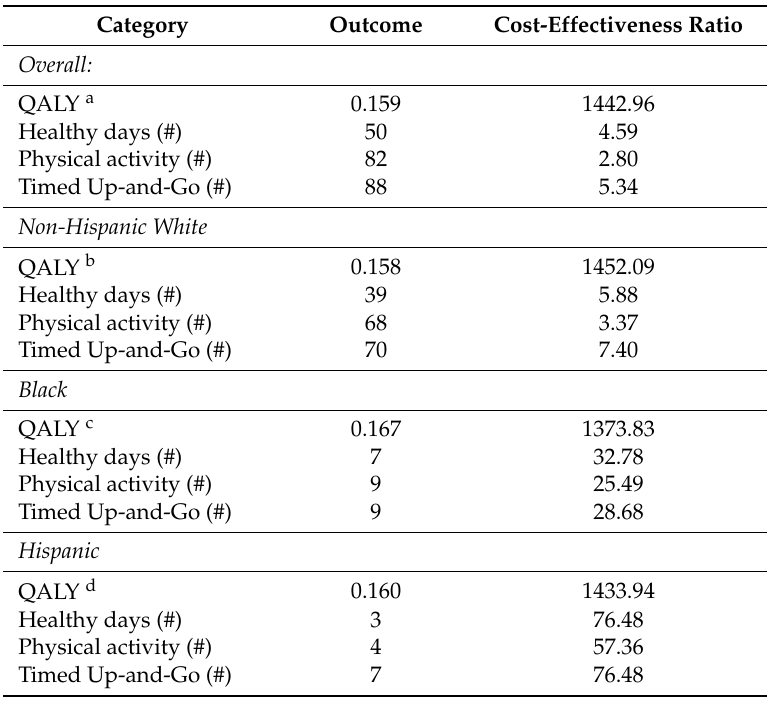
Table 5. Cost-effectiveness